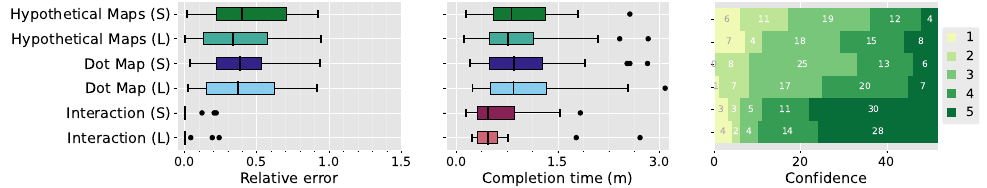
Figure 10. Results of the task measuring the impact of the data variance between geographical